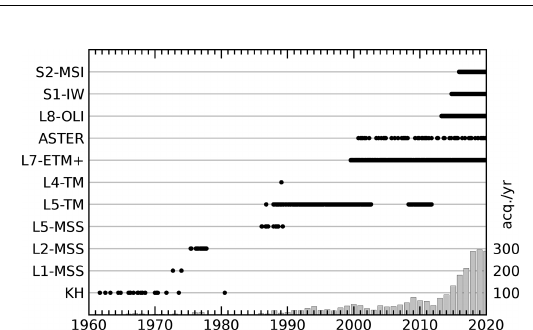
Figure 2. Temporal overview of analyzed satellite imagery. The bar plot indicates the total number of available acquisitions per